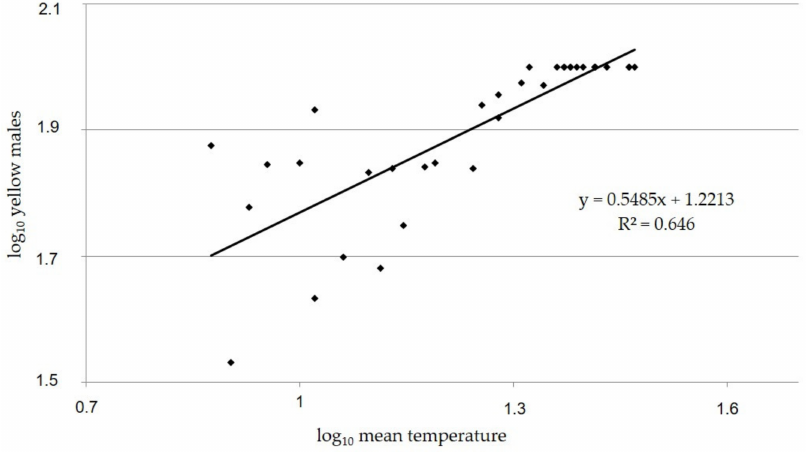
Figure 5. Linear regression between number of yellow males of Cirrospilus pictus and log of mean temperature ( ◦ C) (SIAS) detected in the surveyed field of Citrus spp. in Sicily (Italy) from January 2000 to December